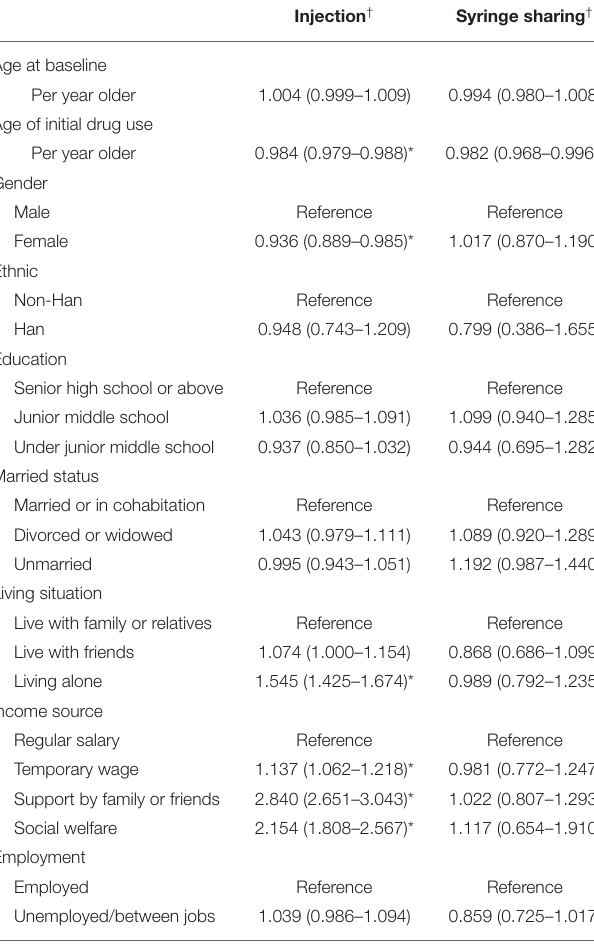
TABLE 3 | Multivariable GEE analyses of factors associated with injection and syringe sharing among drug users on MMT in Wuhan, China,